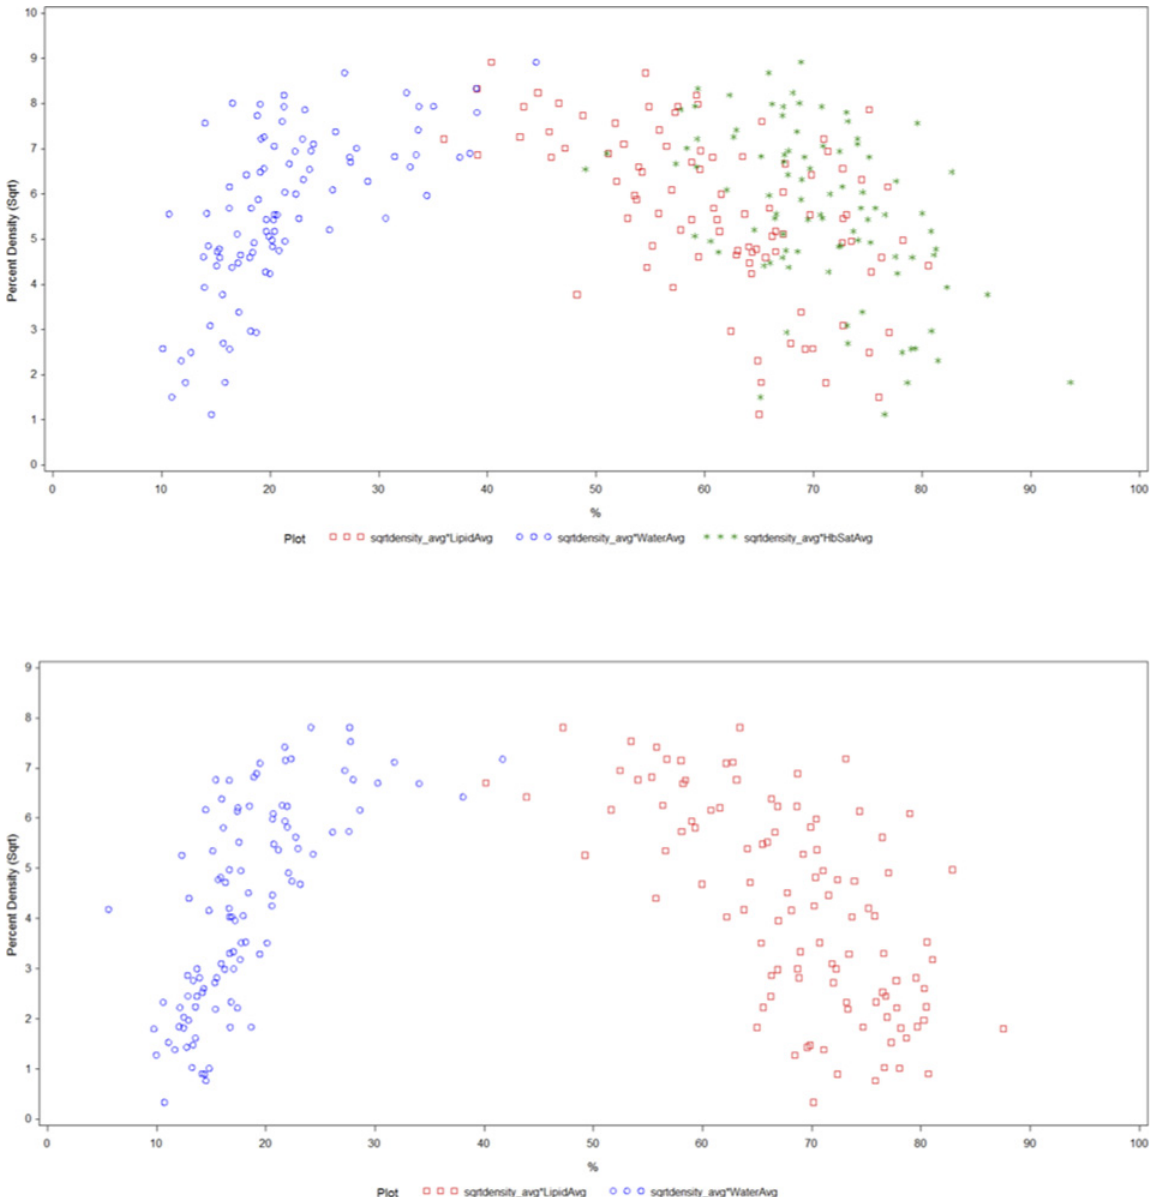
Figure 2. Scatterplot showing the final association of OS chromophore measures [lipid%(red square), water%(blue circle), S t O 2 %(green star)] with PD (square root transformed) in pre (top) and post-menopausal women (bottom) adjusted for BMI.